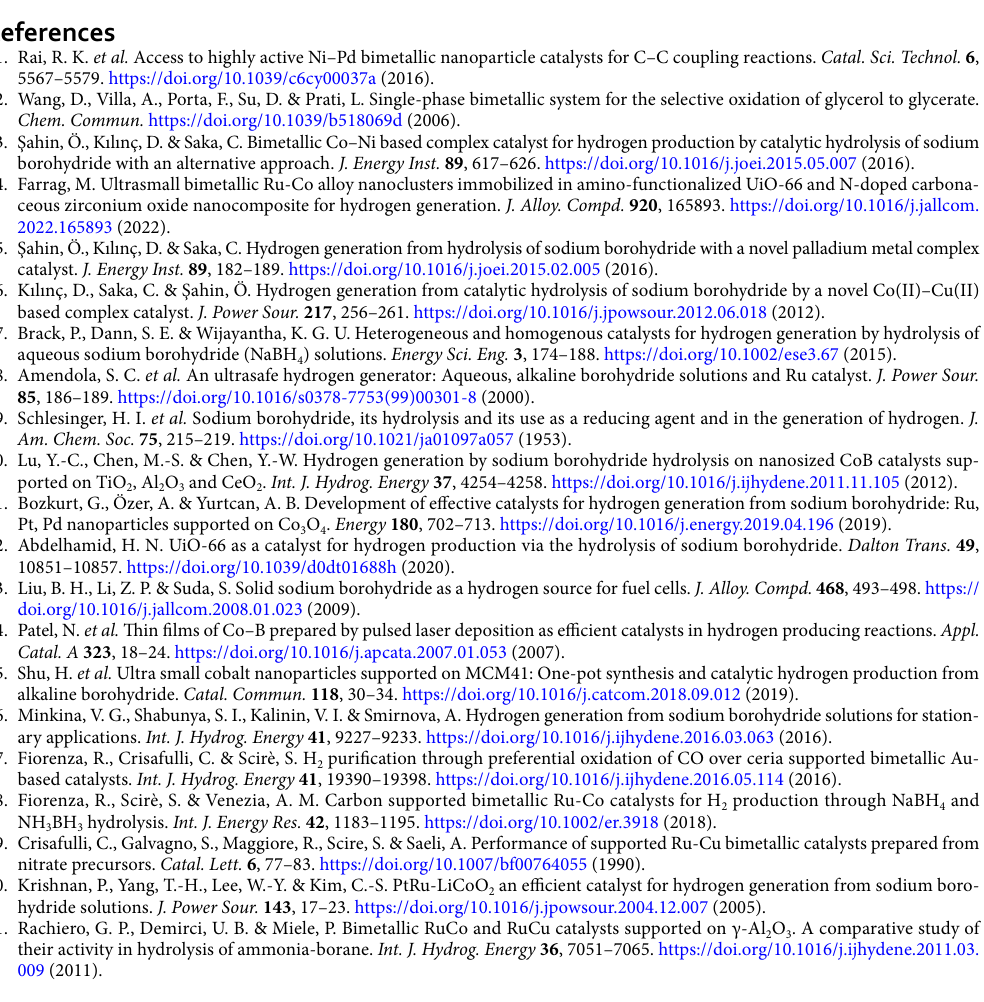
2 min stirring at 60 °C, with HGR 50,000 mL min − 1 g − 1 . The extremely catalytic activity of this catalyst attributes to the ultra-small particle size and the synergistic effect between Pd and Pt atoms in the alloy quantum dots. Data availability All data generated or analyzed during this study are included in this published article (and its Supplementary Information files).